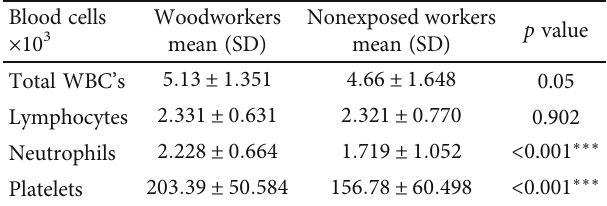
Table 1: Comparison of in fl ammatory cells counts between study